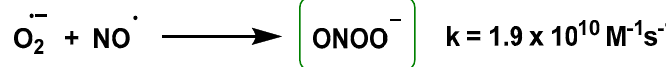
Figure 46. Conversion of nitric oxide to peroxynitrite and rate of reaction.